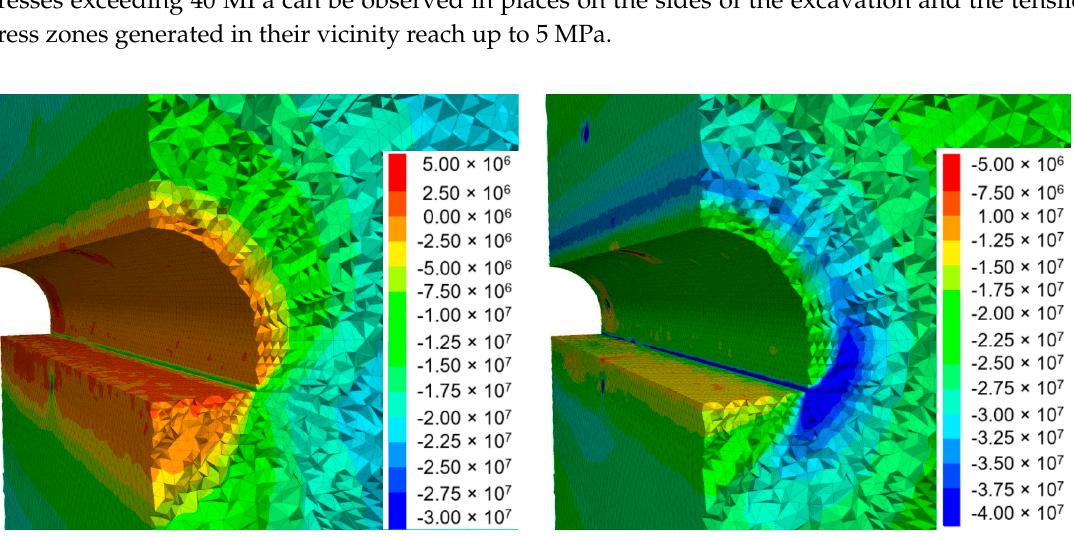
Figure 11. Distribution of the largest and smallest main stresses expressed in pascals for the model with dispersion of strength parameters with a variability coefficient of 25%.